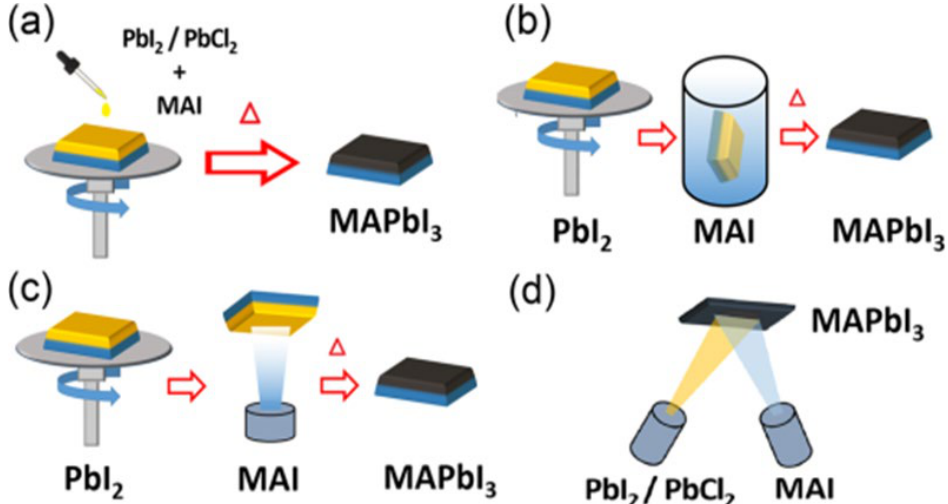
Figure 10. Schematic representation of perovskite solar cell fabrication methods. ( a ) One-step method; ( b ) two-step method; ( c ) vapor-assisted solution method; ( d ) thermal vapor deposition method. Precursor concentrations, coating dipping time, spin coating time, and spinning rates are perovskite film quality or morphology controlling parameters during fabrication [40].